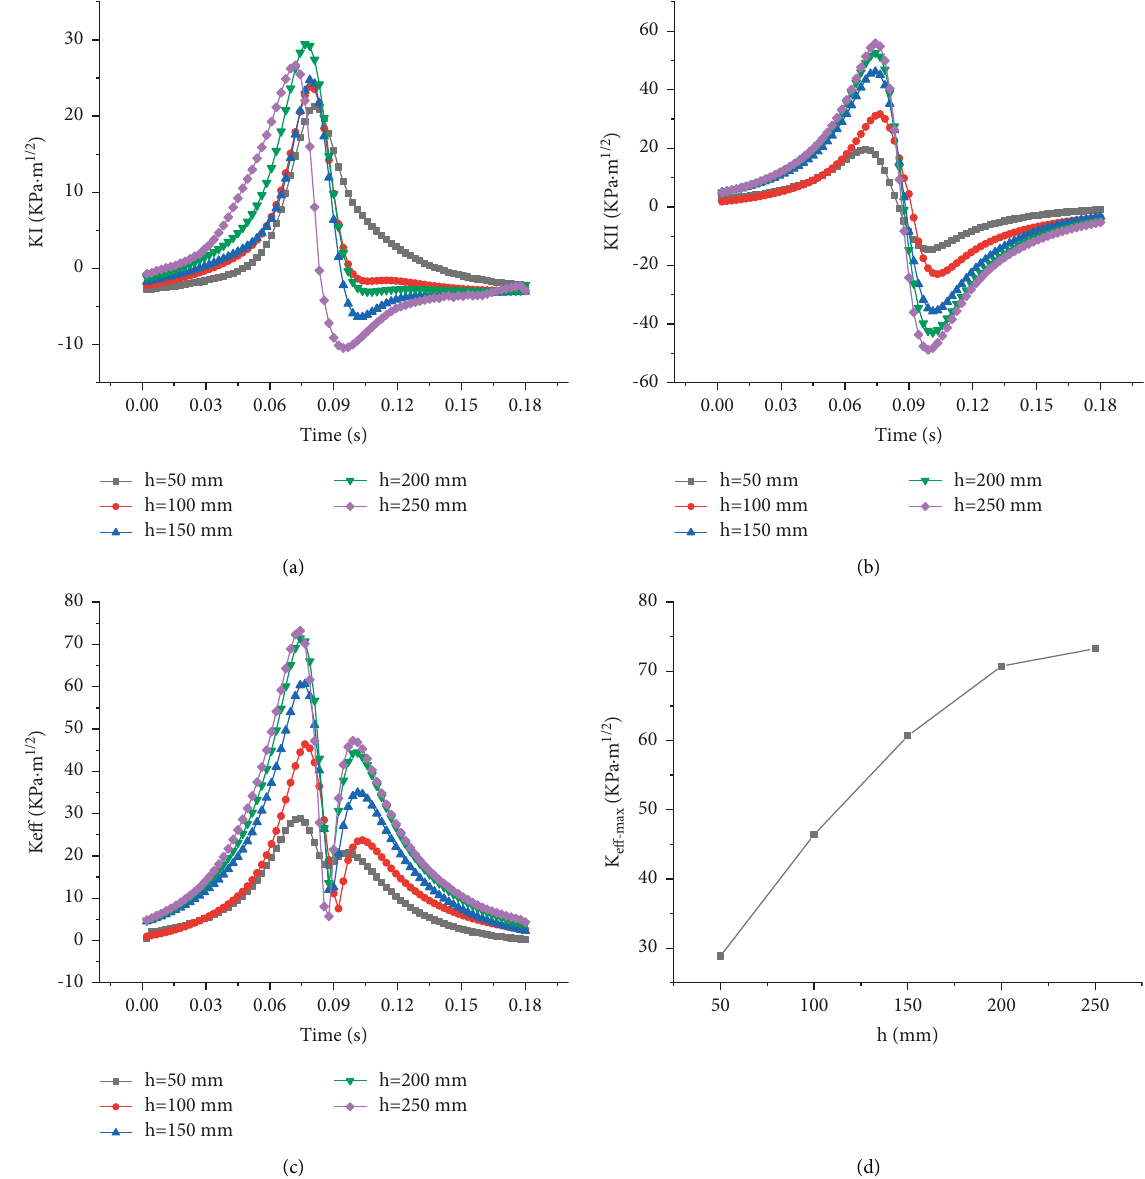
Figure 7: The SIF of nonpenetrating crack time history curve with various lengths. (a) KI; (b) KII; (c) Keff; (d)